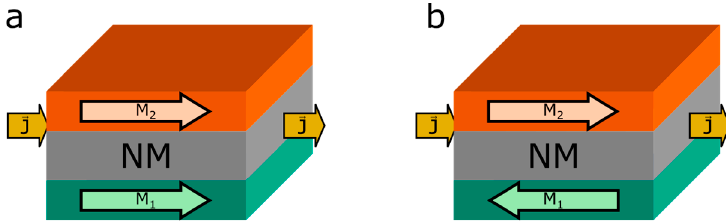
Figure 1. GMR double layer in Current in Plane (CIP) configuration. ( a ) Layer magnetization parallel; ( b ) antiparallel in respect to each other.